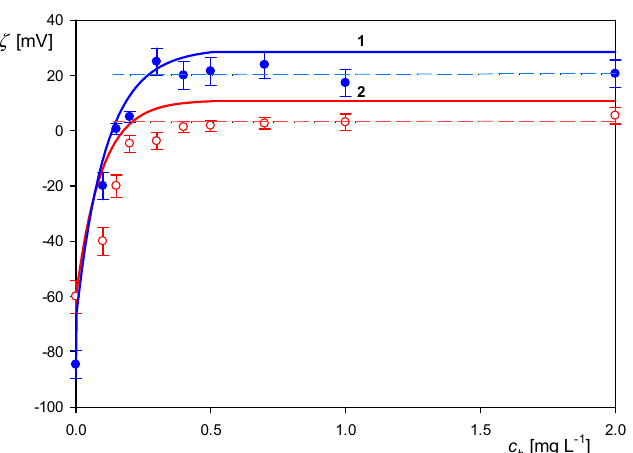
Figure 4. Dependence of the zeta potential of the particles on the bulk myoglobin concentration: (1). ● 0.01 M, NaCl, (2). ○ 0.15 M, pH 3.5. The points denote experimental data derived from the (1). • 0.01 M, NaCl, (2). 0.15 M, pH 3.5. The points denote experimental data derived (cid:35)